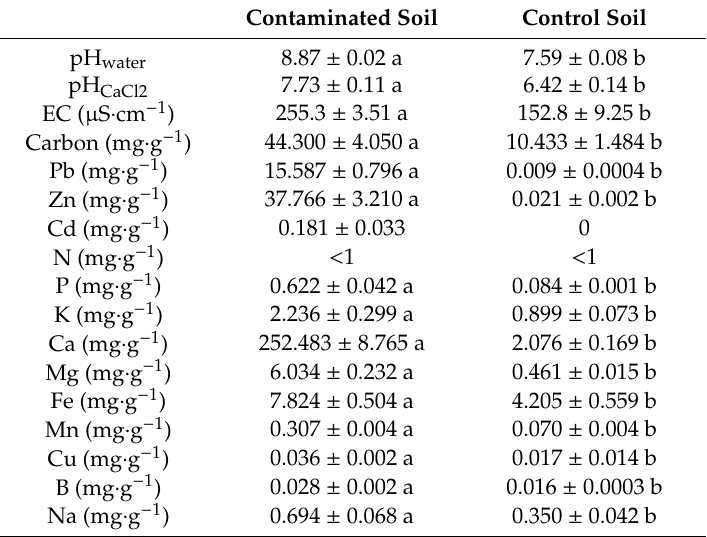
Table 1. Physicochemical characteristics of the contaminated and control